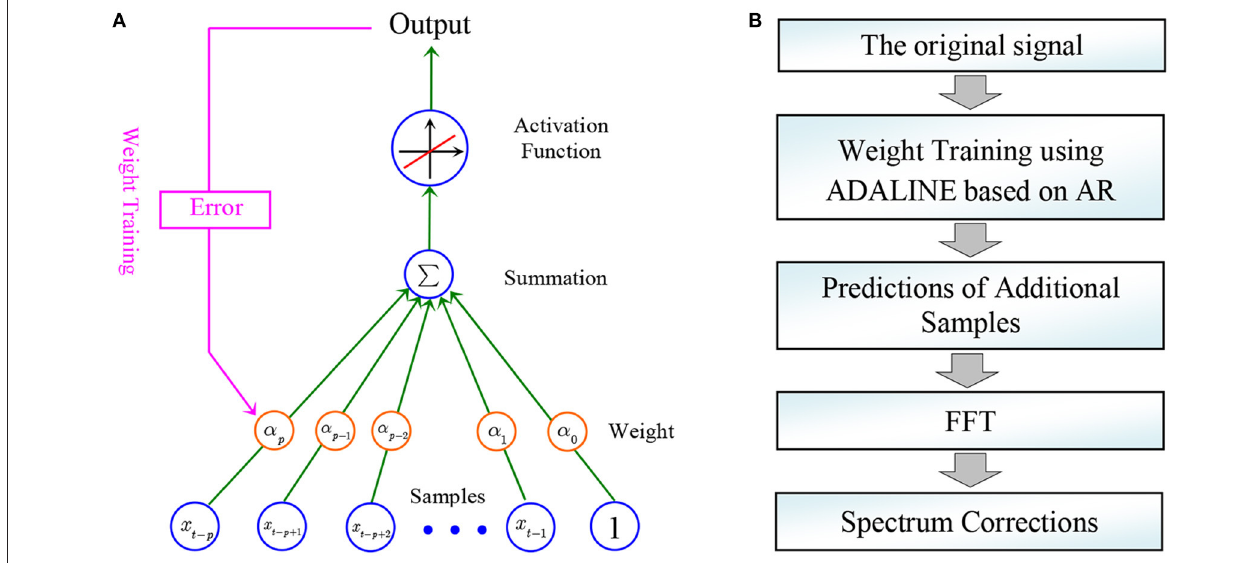
FIGURE 1 | (A) The structure of a typical adaptive linear neuron; (B) The procedure of the proposed